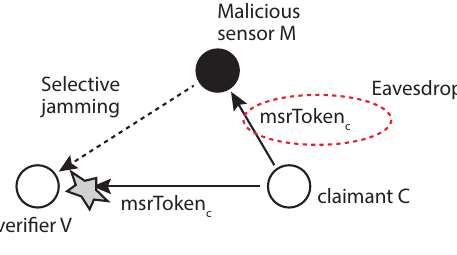
Figure 11. An example of sniffing on the